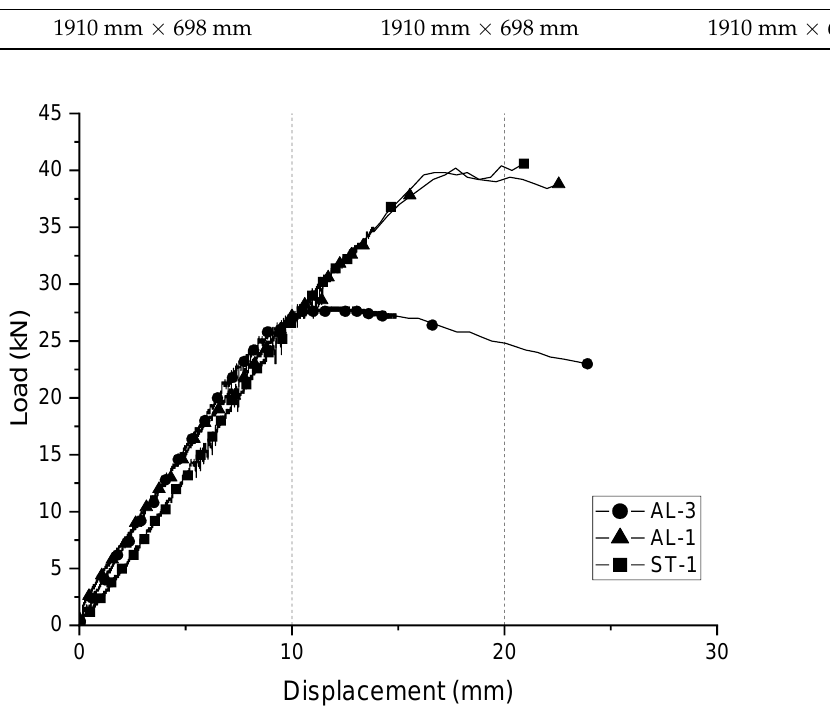
Figure 9. Load–vertical displacement curves of